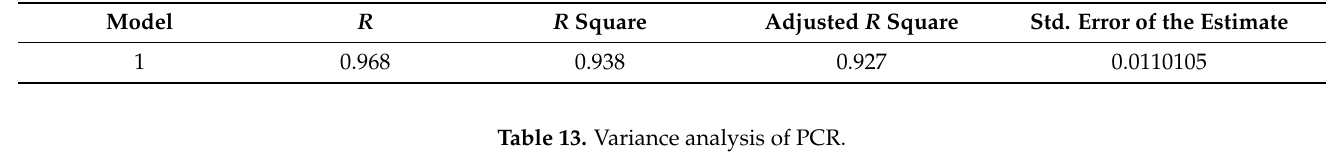
Figure 9. Scree plot of the PCR model. Table 12. Model summary of the PCR.